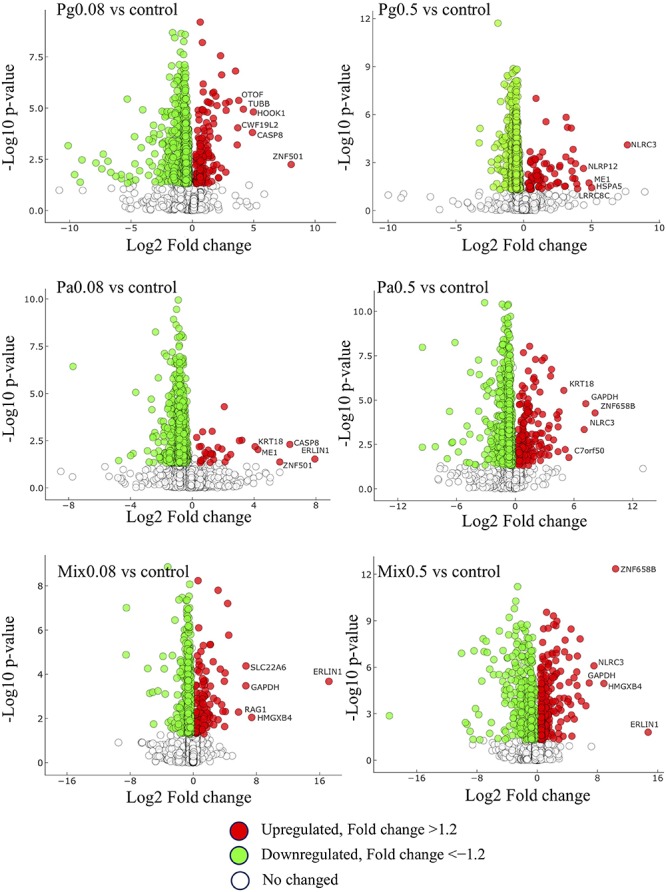
Distribution of up- and down-regulated proteins and their P values. Fold changes are relative to extract-based diets versus control diet. Pg, P. guajava; Pa, P. amarus; Mix, mixture of P. guajava and P. amarus. Proteins satisfying |fold change| ≥ 1.2 and p < 0.05. The horizontal and vertical axis represent log2Fold-change and −log10P-value, respectively.